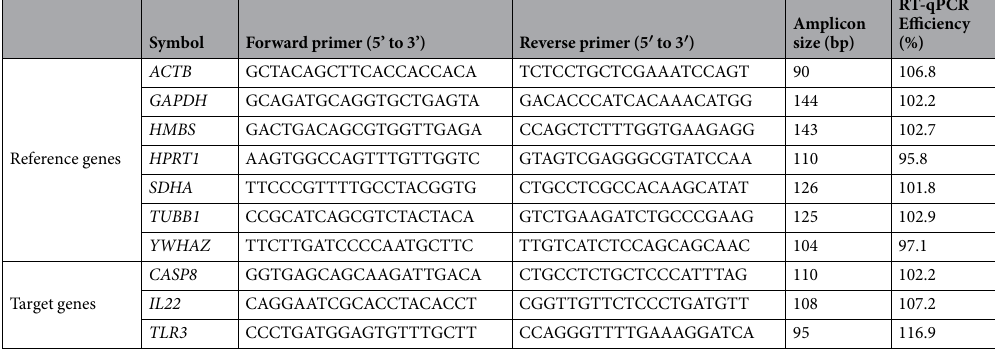
Table 3. Primer sequences for target and reference genes used for RT-qPCR.